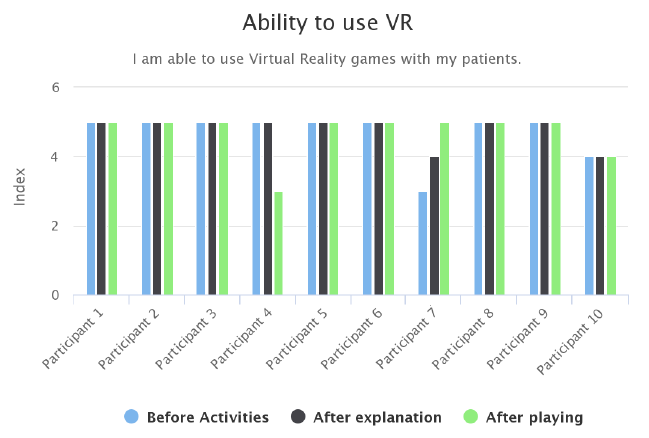
Figure 6: Physiotherapists opinion about their abilities to use VR with their patients before and after the experiment activities